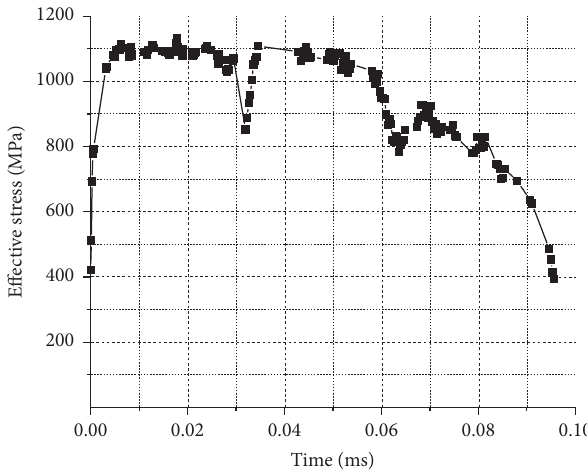
Figure 23: Effective stress-time history curve of point P1.